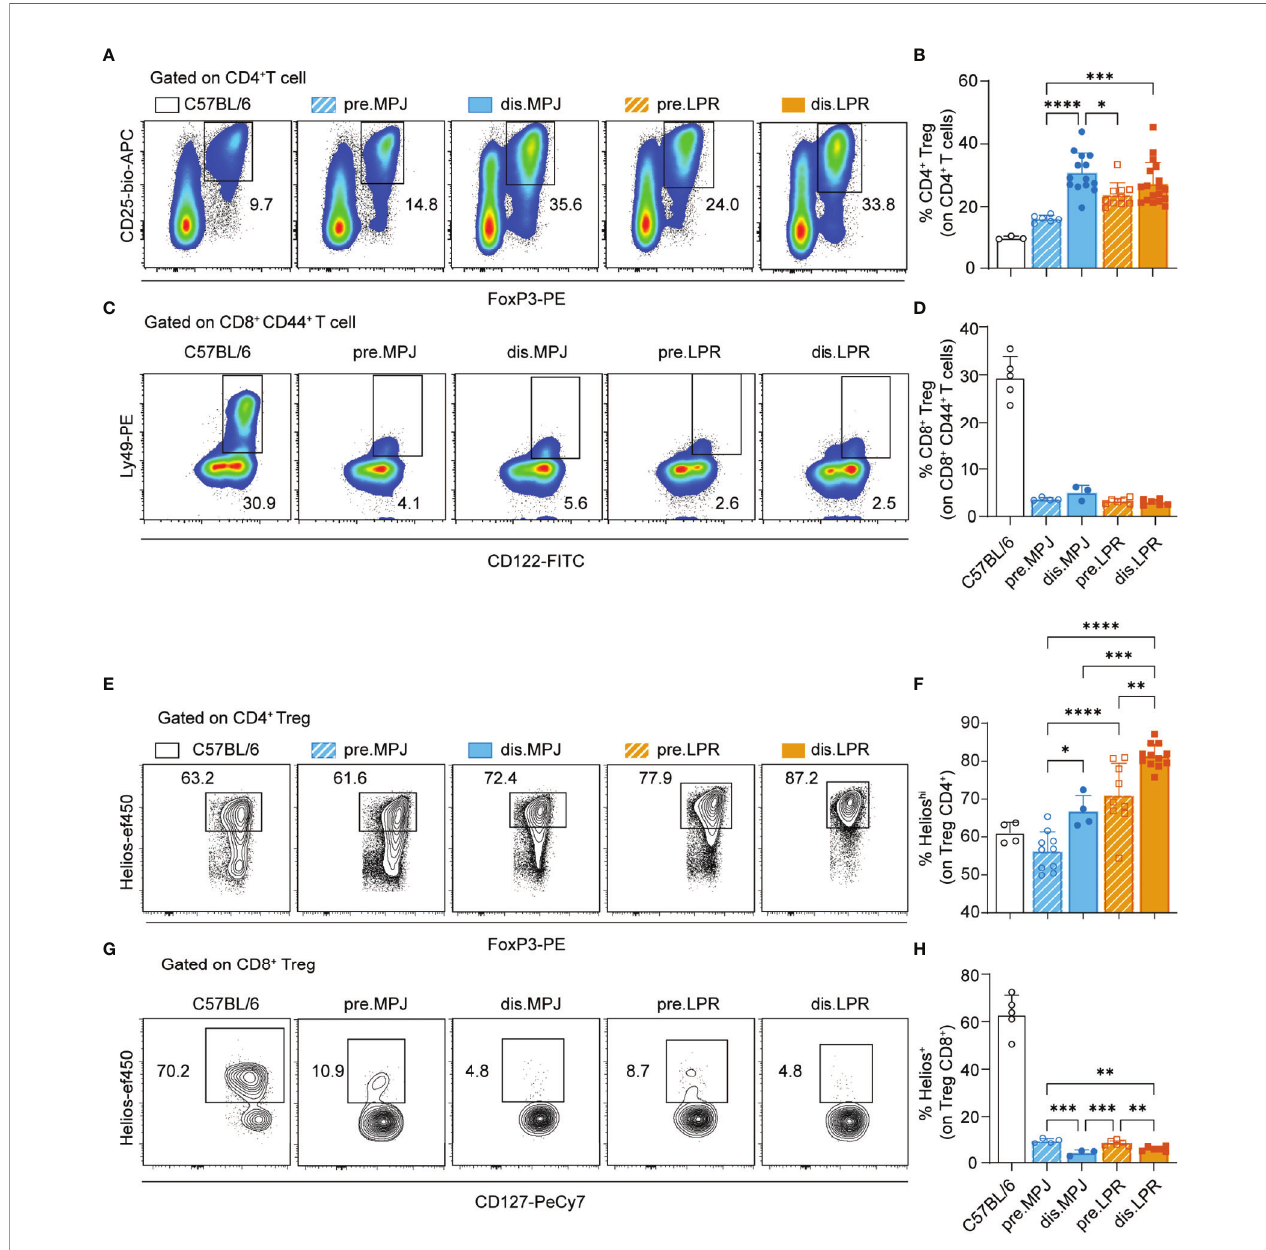
FIGURE 4 | Helios expression in CD4 + and CD8 + Tregs from MPJ and LPR mice. (A) Representative fl ow cytometry plots pregated on splenic CD4 + T cells (CD3 + CD8 − CD4 + ). The CD4 + Treg (CD25 + FoxP3 + ) gates are indicated. (B) Percentage of CD4 + Tregs among the CD4 + T cells. (C) Representative fl ow cytometry plots pregated on splenic CD8 + CD44 + T cells (CD3 + CD8 + CD44 + ), in which the CD8 + Treg (CD122 + Ly49 + ) gates are indicated. (D) Percentage of CD8 + Treg among CD8 + CD44 + T cells. (E) Representative fl ow cytometry plots pregated on CD4 + Tregs with the Helios hi gate indicated. (F) Percentage of Helios hi cells among CD4 + Tregs. (G) Representative fl ow cytometry plots pregated on CD8 + CD127 + Tregs, with the Helios + gate indicated. (H) Percentage of Helios + cells among CD8 + Tregs. The data represent the mean ± SD: *P < 0.05, **P < 0.01; ***,P < 0.001; ****,P < 0.0001 for comparisons between MRL animals. One-way ANOVA with a Tukey multi-comparison post-test was used. Each point represents a single animal: C57BL/6, n = 3 (A, B) , 5 (C, D) , 4 (E, F) , and 5 (G, H) ; prediseased MPJ (pre.MPJ), n = 6 (A, B) , 4 (C, D) , 10 (E, F) , and 4 (G, H) ; diseased MPJ (dis.MPJ), n = 14 (A, B) , 3 (C, D) , 4 (E, F) , and 3 (G, H) ; prediseased LPR (pre.LPR), n = 10 (A, B) , 4 (C, D) , 9 (E, F) , and 4 (G, H) ; and diseased LPR (dis.LPR), n = 18 (A, B) , 6 (C, D) , 12 (E, F) , and 6 (G, H)